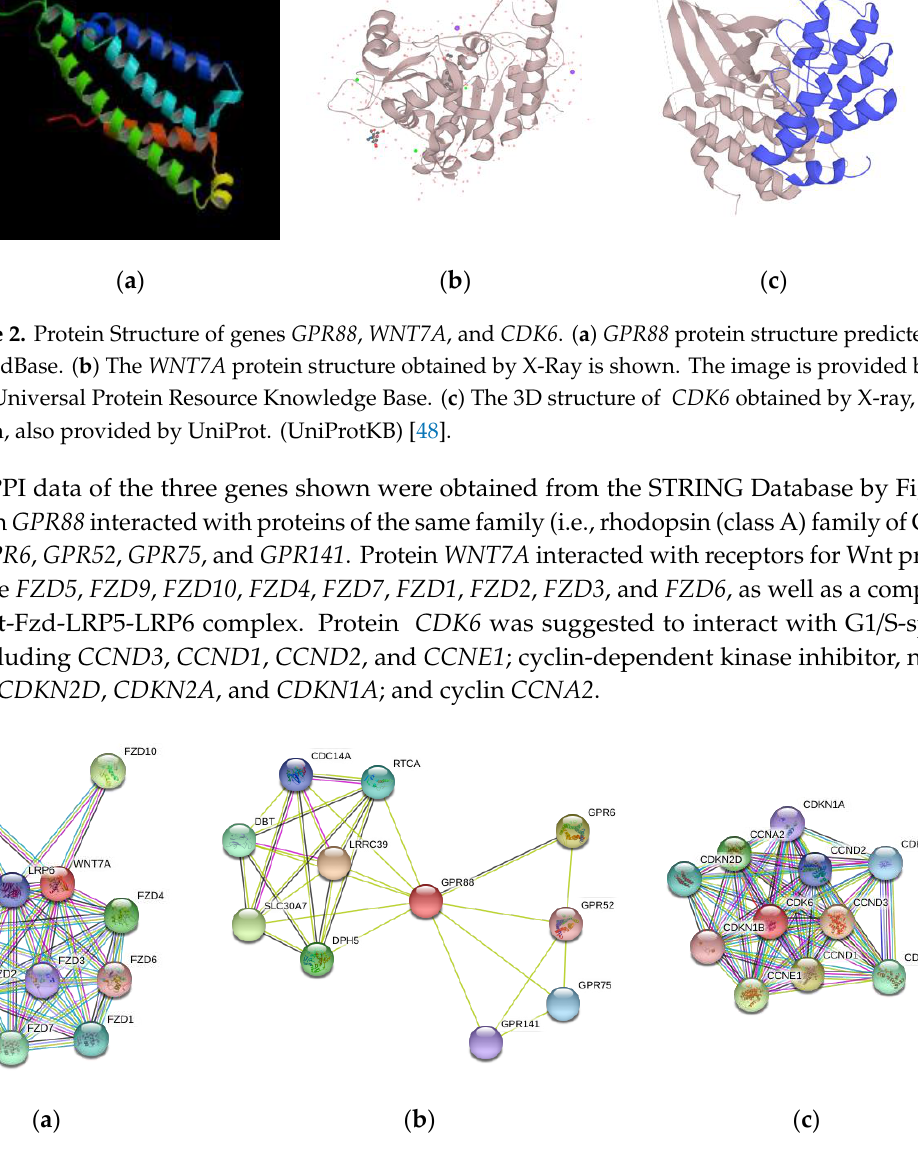
Figure 3. Protein–protein Interaction Data of GPR88, WNT7A, and CDK6. ( a ) Protein GPR88 interacts with proteins of the same family (i.e., rhodopsin (class A) family of GPCR). ( b ) Protein WNT7A interacts with receptor for Wnt proteins as well as component of the Wnt-Fzd-LRP5-LRP6 complex ( c ) Protein CDK6 interacts with G1/S-specific cyclin, cyclin-dependent kinase inhibitor, and Cyclin.